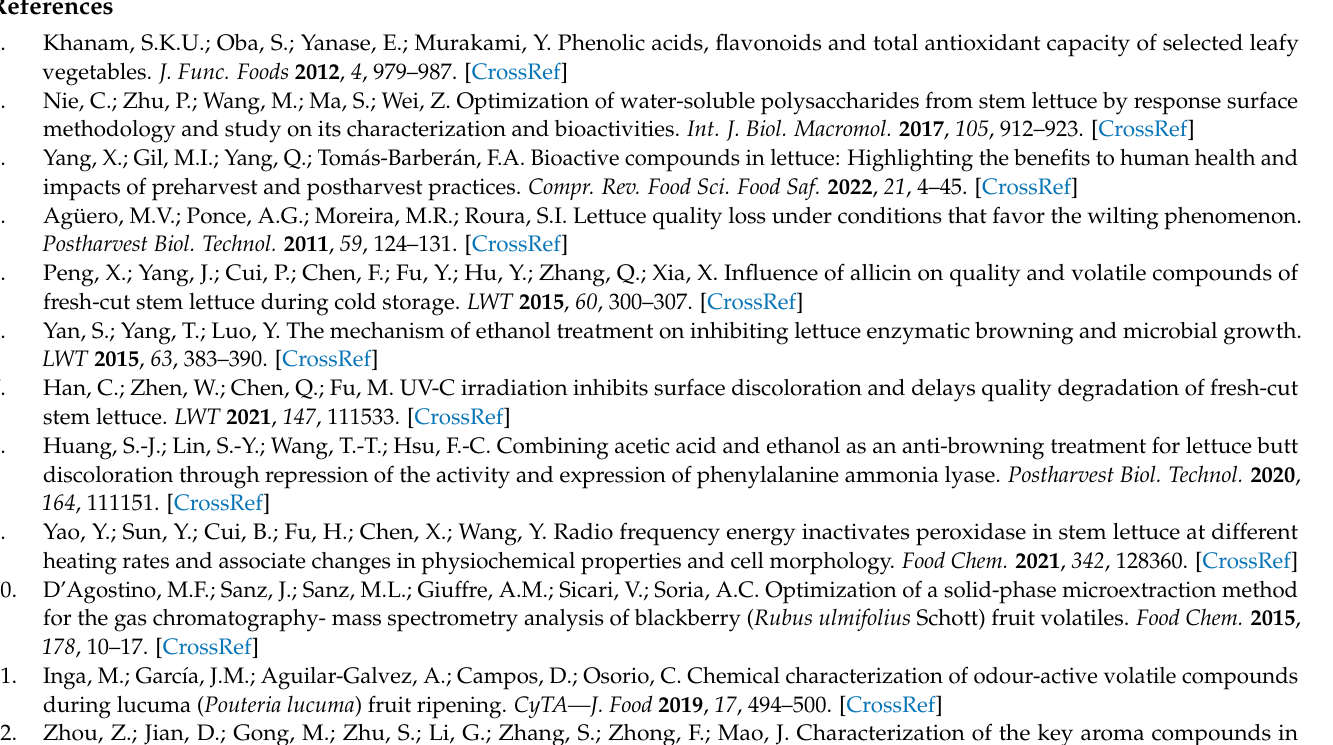
Figure S1: Appearance of fresh-cut stem lettuce treated with different concentrations of diacetyl for 12 d at 4 ◦ C. Figure S2: Effects of diacetyl treatment on PPO activity during storage time at 4 ◦ C. Vertical bars represent standard